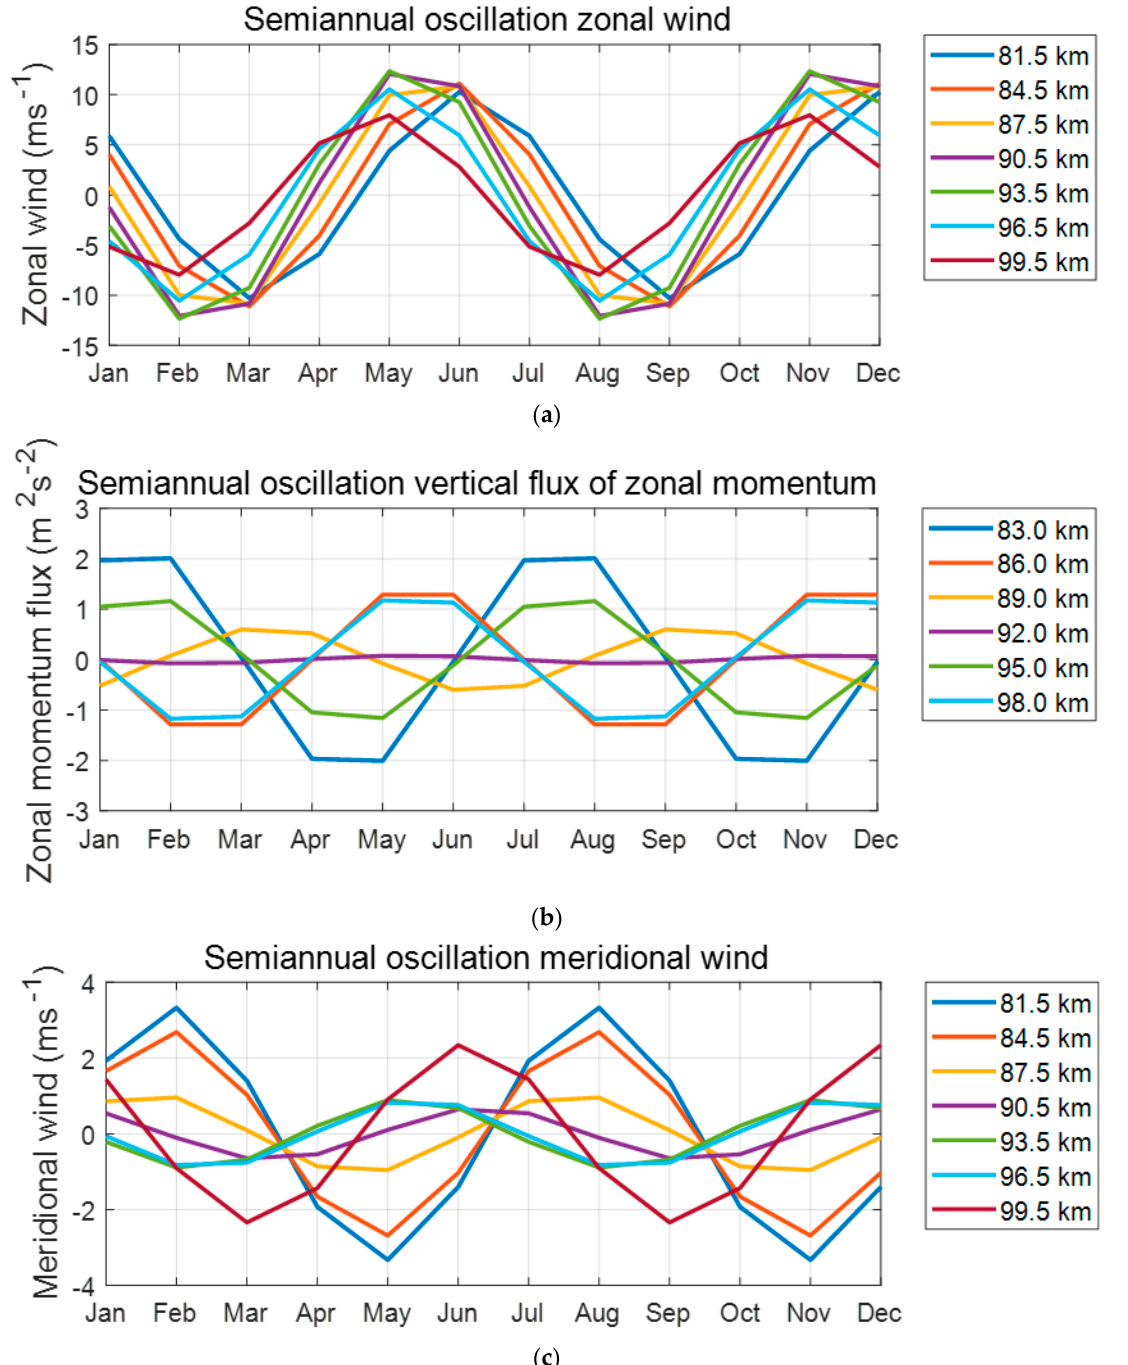
Figure 5. Semiannual oscillation (SAO) components of zonal wind ( top ), zonal momentum flux ( middle ), and meridional wind ( bottom ) at varying altitudes. ( a ) Semiannual oscillation zonal wind; ( b ) Semiannual oscillation vertical flux of zonal momentum; ( c ) Semiannual oscillation meridional wind.